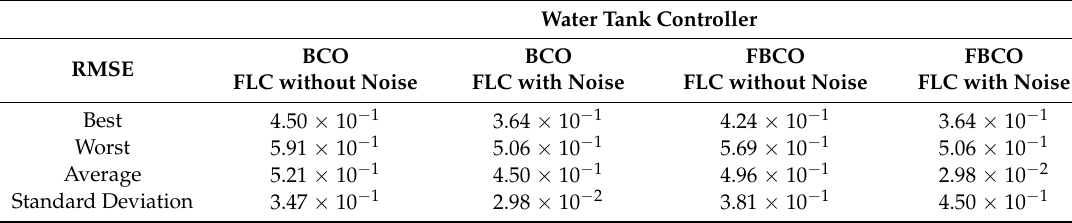
Table 6. Results obtained from the water tank controller by BCO and FBCO